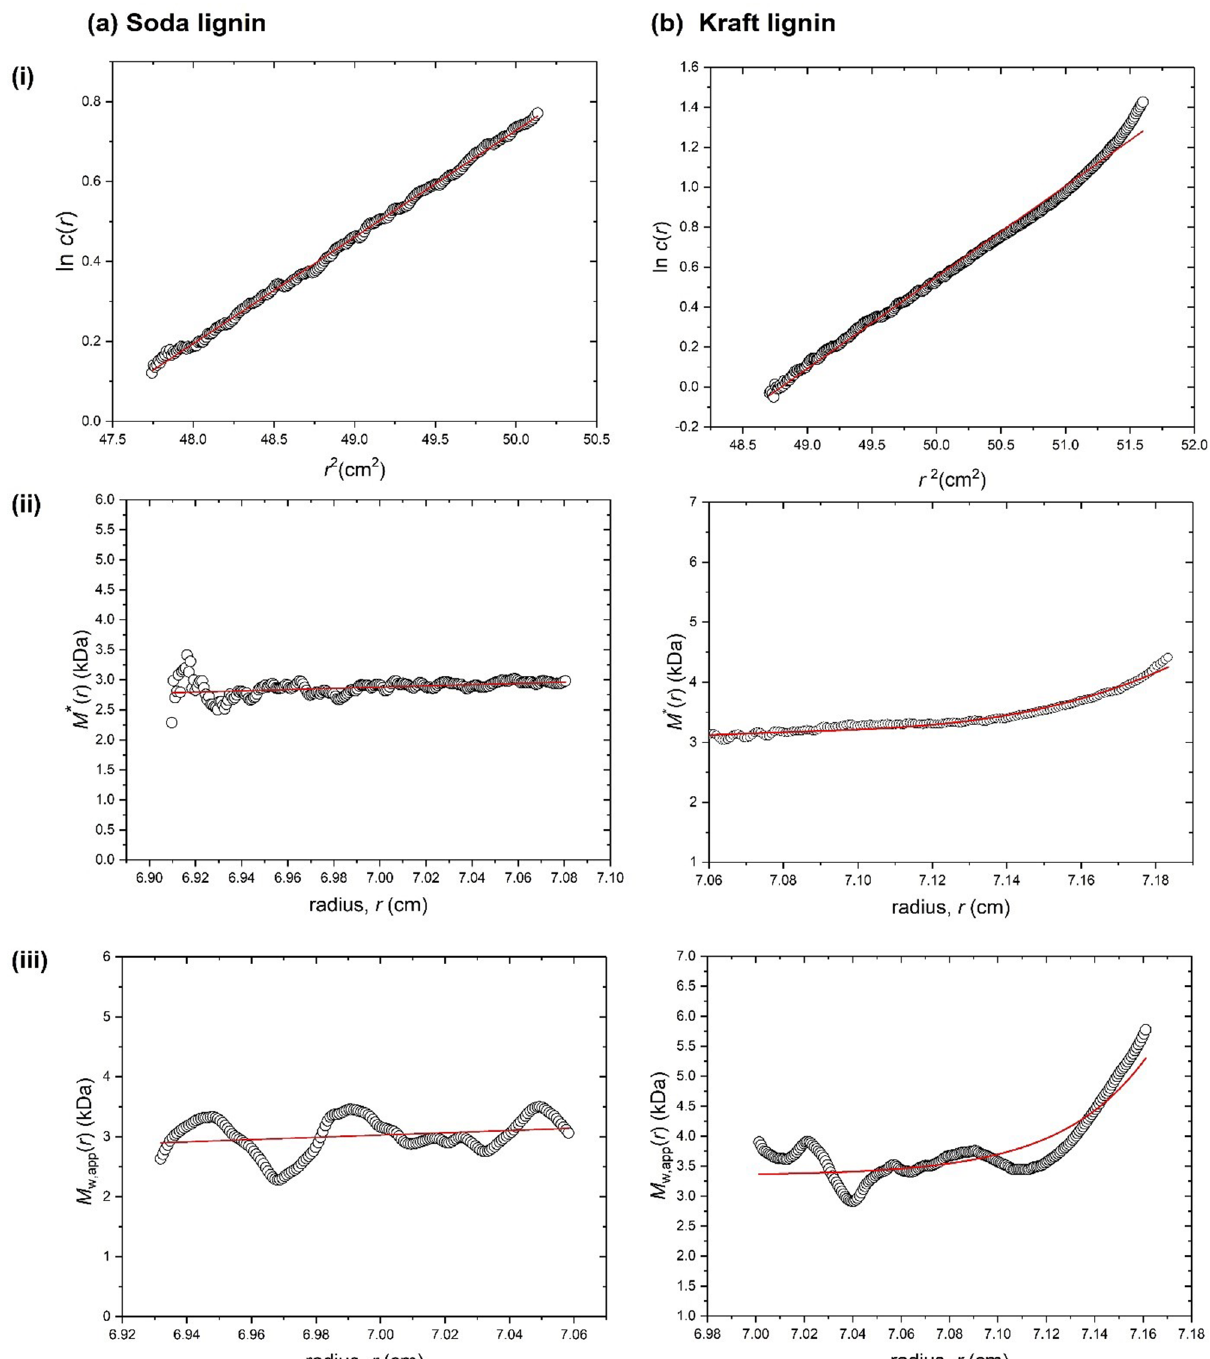
Figure 1. Sedimentation equilibrium SEDFIT-MSTAR output for the analysis of ( a ) P1000 soda lignin; and ( b ) Indulin AT Kraft lignin in DMSO:water (9:1) at 20 °C at loading concentrations of 0.65 mg mL −1 in 12 mm pathlength cells. (i) log concentration, c, versus the square of the radial displacement, r ; (ii) extrapolation of the M * function to the cell base to yield the whole distribution apparent weight average molar mass M w,app ; and (iii) plot of the point average molar mass (local molar mass), obtained by taking the derivative of the data from plot (i) versus the local concentration c ( r ) in the analytical ultracentrifuge cell. The value at the ‘hinge point’ (where c ( r ) = cell loading concentration) yields the value for the whole distribution M w values shown in Table